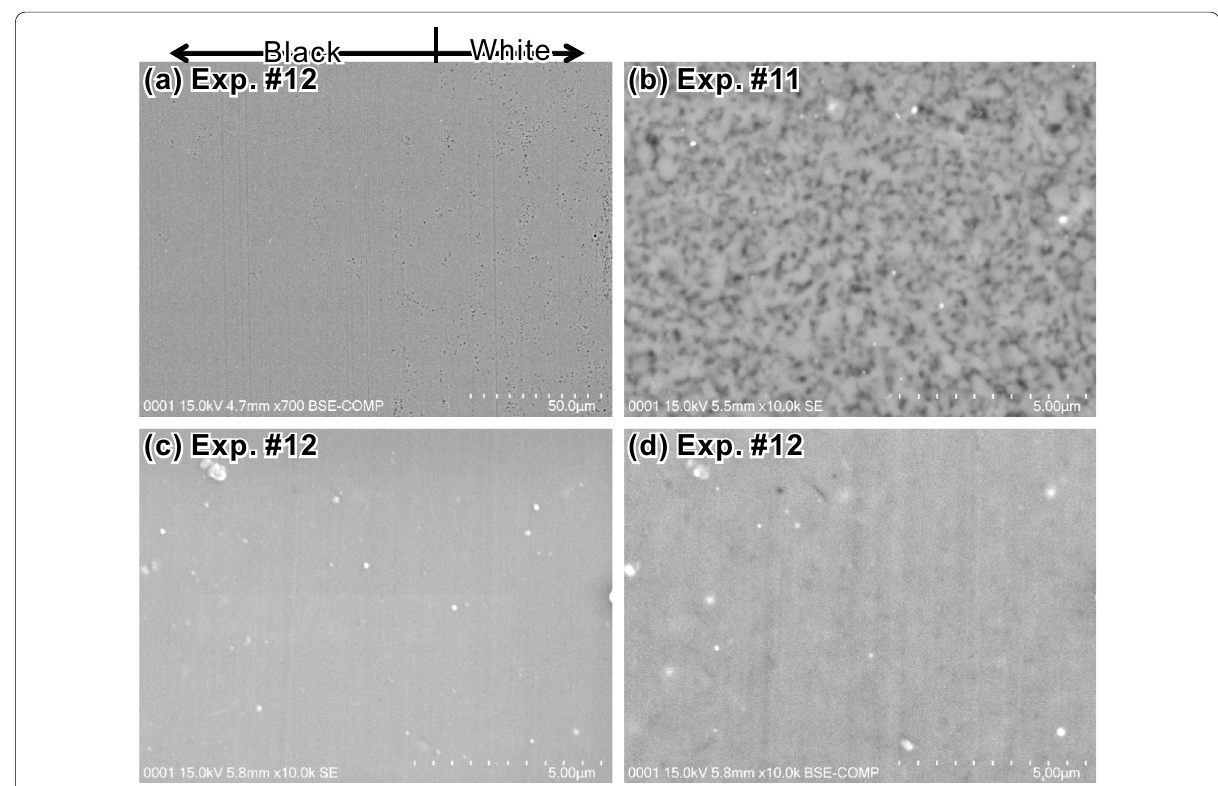
Fig. 10 SEM images of samples prepared from the powders after 24 h of decantation that were hot‑pressed with CAS conditions at 1080 °C and 100 MPa for 36 (Exp. #11) or 38 (Exp. #12) hours. a SEI of the boundary region between black (left) and white (right) coloured parts (see Fig. 4f). b SEI of the white coloured part of the sample. c SEI of the black coloured part of the sample. d BEI of the same place as ( c